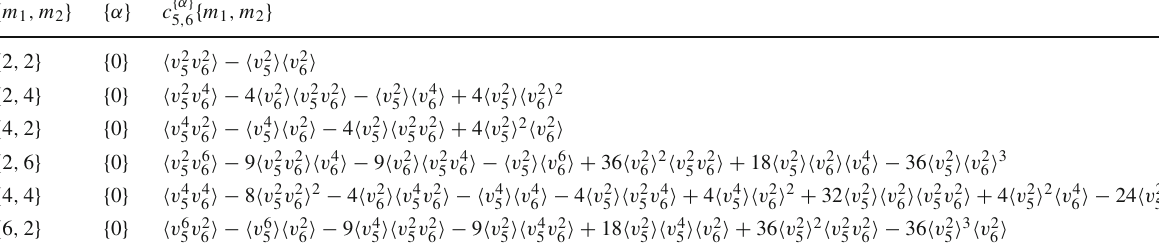
Table 5 Three-harmonic cumulants up to order